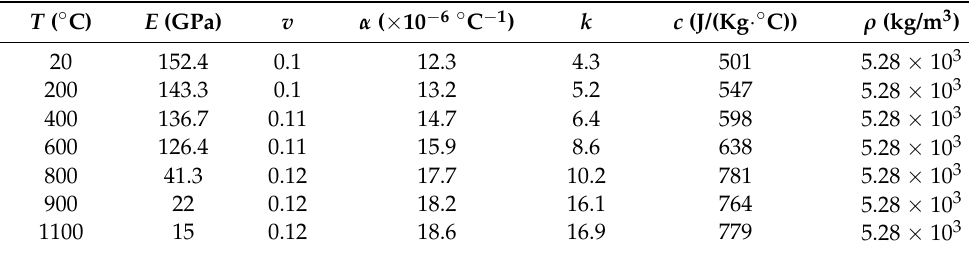
Table 2. Material parameters of NiCoCrAlY for BC layer [45–48].